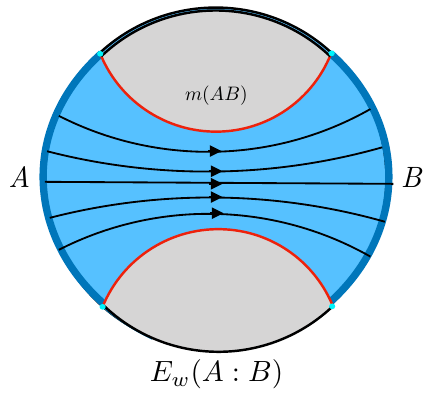
Figure 4 . A maximal (cid:13)ow of (2.8) whose (cid:13)ux calculates E